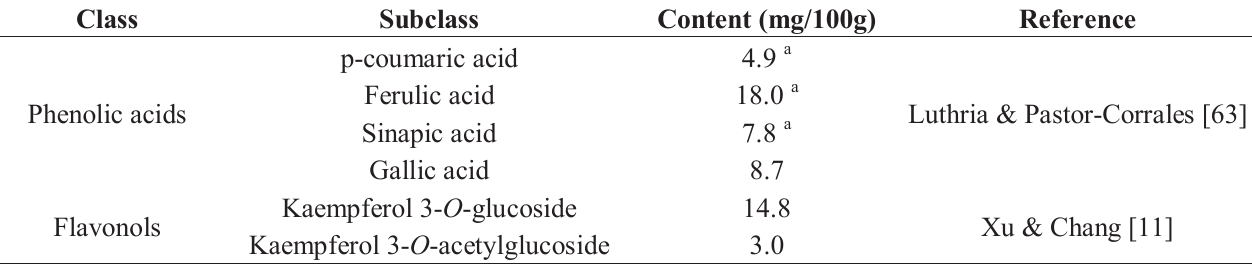
Table 2. Main phenolic compounds present in pinto